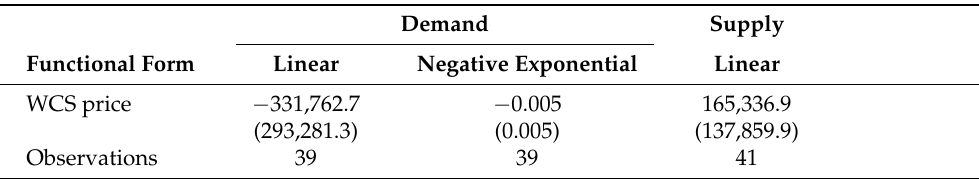
Table 2. Instrumental Variable Coefficients from Second-stage Demand and Supply Models, yielding Elasticities in Table